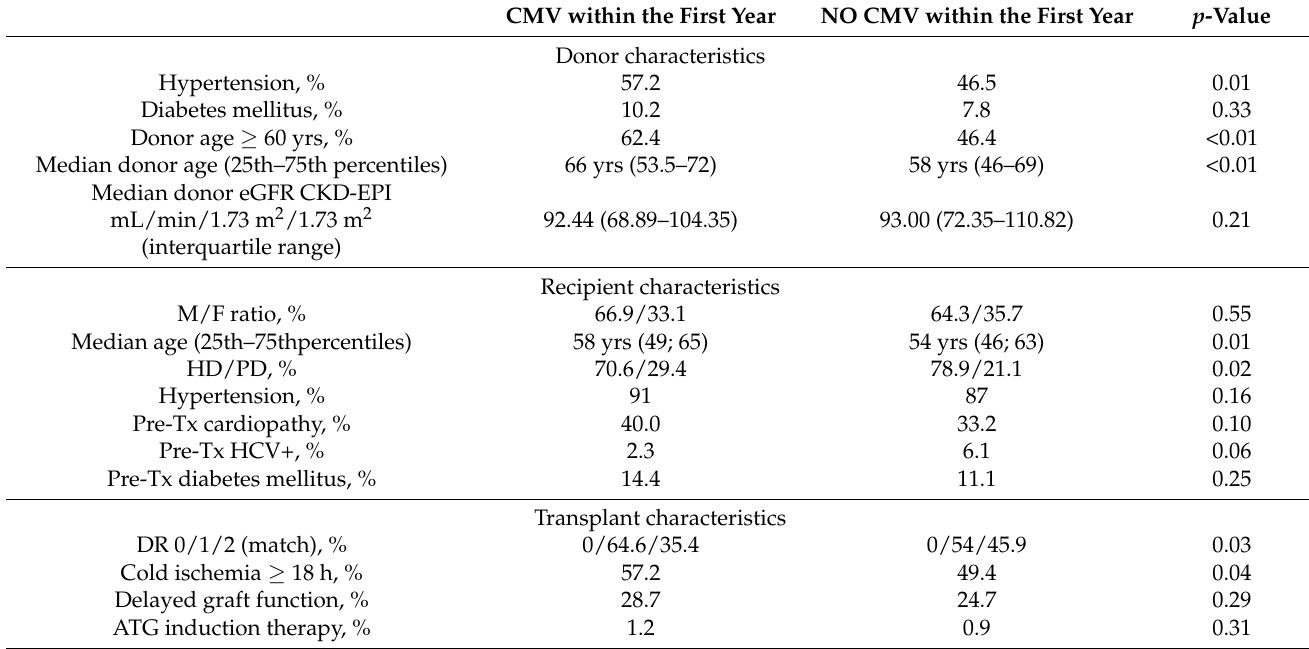
Table 1. Main characteristics of patients with or without CMV replication/disease in the first year after transplantation. CMV within the First